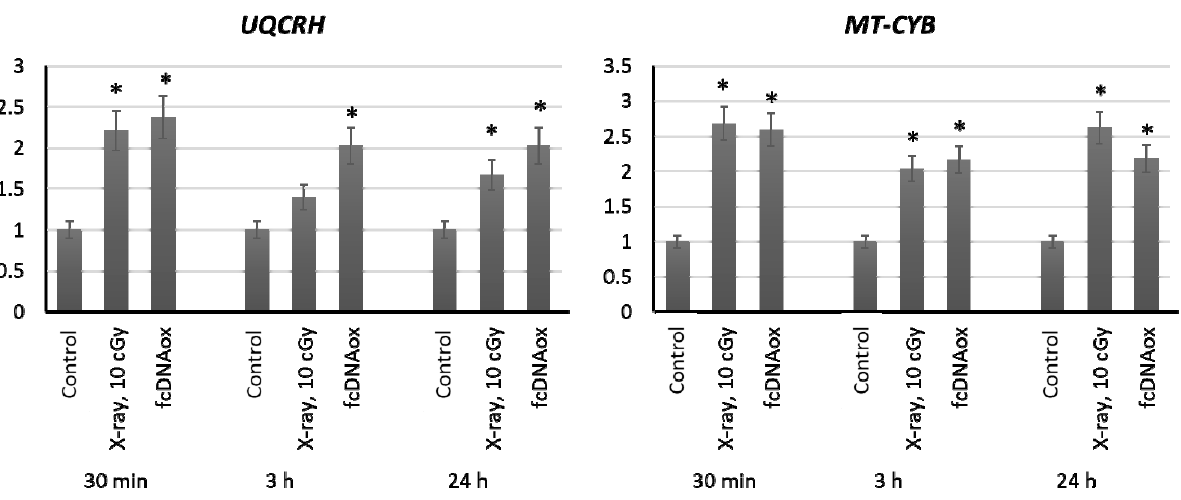
Figure 4. The expression of genes of the mitochondrial respiratory Complex III influenced by low-dose radiation (10 cGy) and oxidized cfDNA (50 ng/mL) assessed by real-time PCR. The genes are indicated in the figure. Ratios to control values are presented. The TBP gene was used as an internal standard gene. Mean values were calculated from five independent measurements; (*) denotes a significant difference from control experiments, p < 0.001, nonparametric U-test.